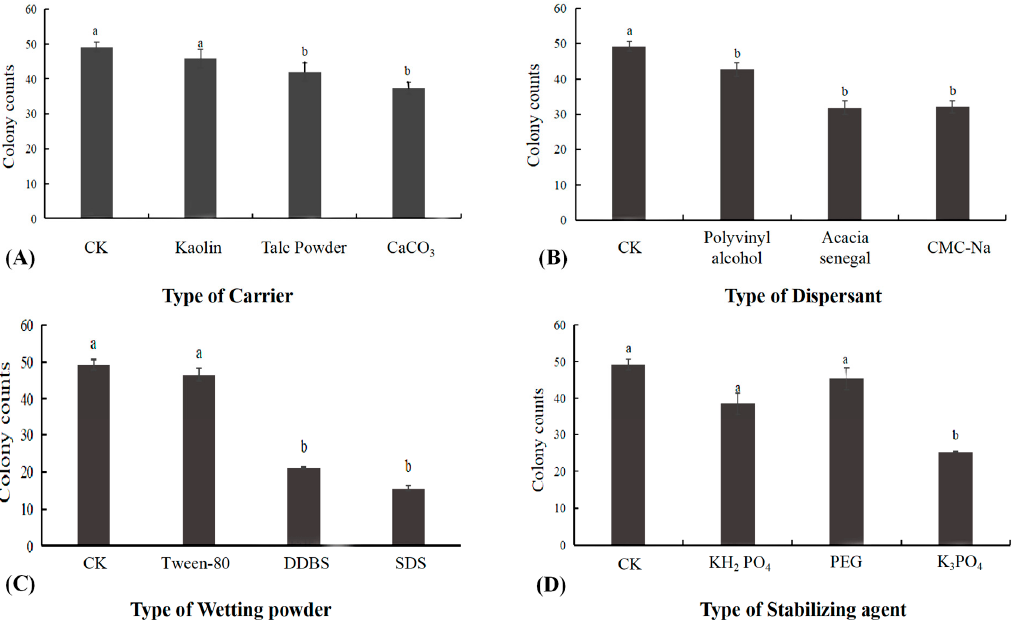
Figure 7. ( A ) The effect of different carriers on biocontrol activity; ( B ) The effect of different dis- persants on biocontrol activity; ( C ) The effect of different wetting powders on biocontrol activity; ( D ) The effect of different stabilizing agents on biocontrol activity. Different letters above the bars indicate significant differences at p < 0.05 (according to Duncan’s multiple range test). Table 1. The optimization ratio of carrier and additive by the orthogonal test.